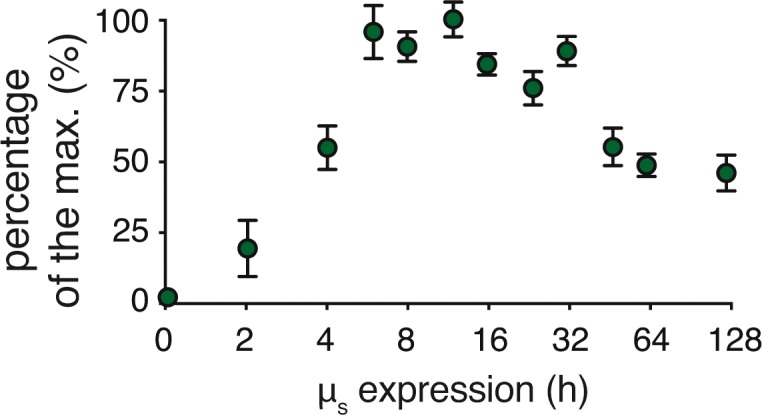
Transitioning from acute, full-geared to chronic, submaximal IRE1α signaling upon µs expression.Percentages of XBP1 mRNA splicing in Figure 4C and replicate experiments were quantified and expressed in percentages of the maximal XBP1 mRNA splicing that was reached. Mean and s.e.m. are shown (n = 3–22 depending on the time point assessed).